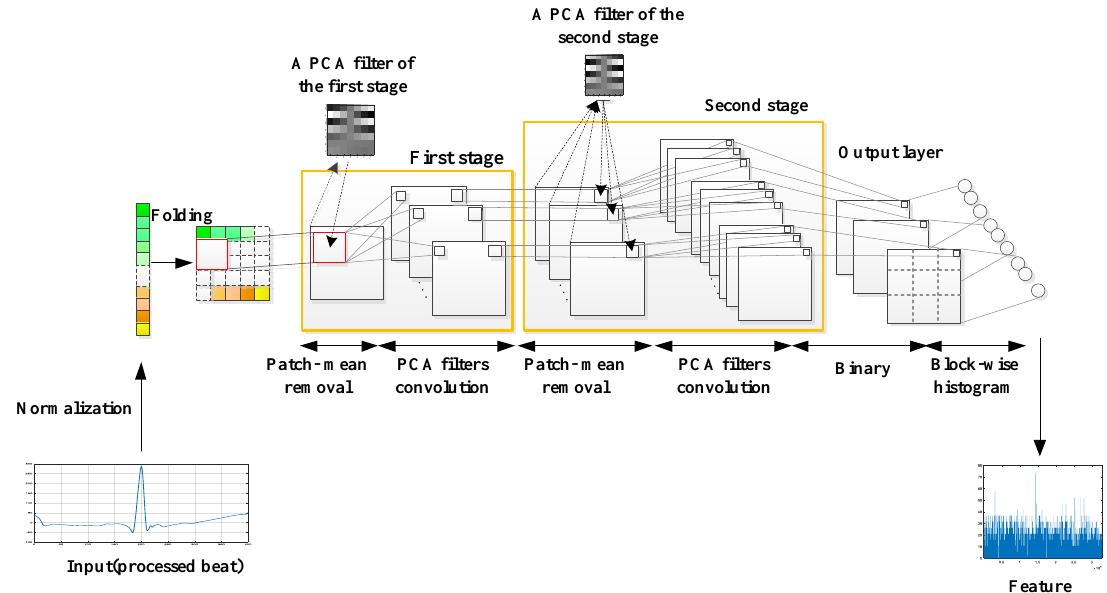
Figure 5. The structure of Principal Component Analysis Network (PCANet) model for ECG feature extraction.